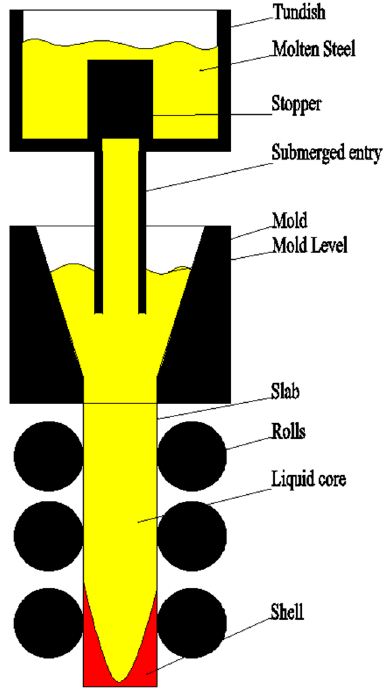
Figure 1. Mold level model.